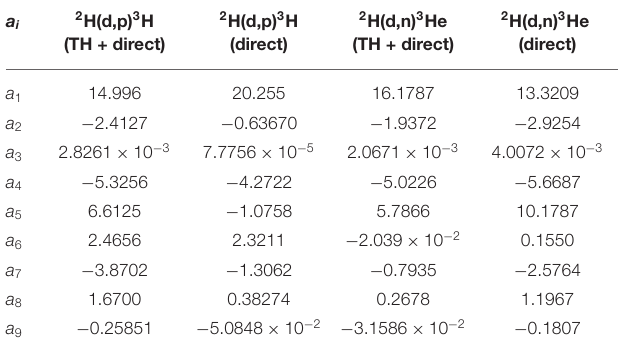
TABLE 3 | Parameters of the reaction rates of Equation (7) for 2 H(d,p) 3 H and 2 H(d,n) 3 He evaluated from the S-factors from TH + direct measurements and from direct measurements.